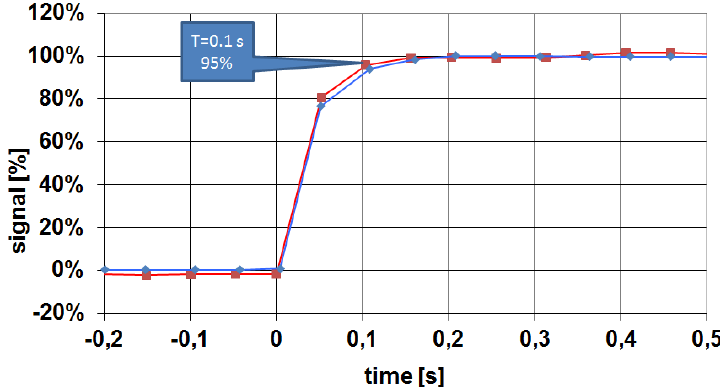
Figure 11. Measured response time of the Coriolis flow sensor; the same sensor was measured twice; 100% equals 1,000